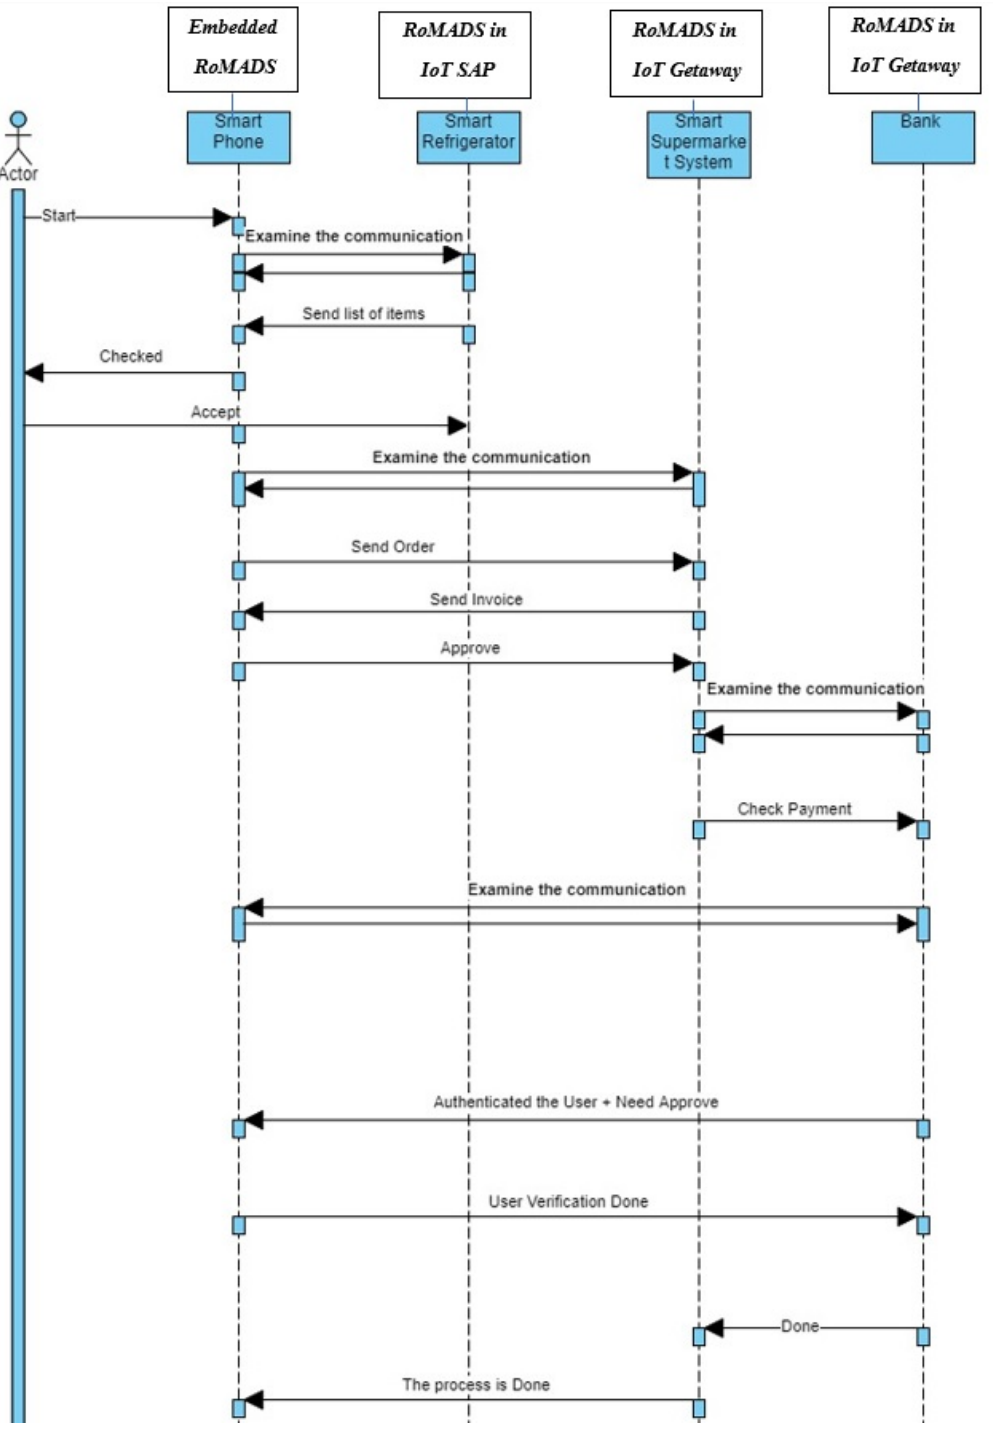
Figure 20. RoMADS sequence diagram.